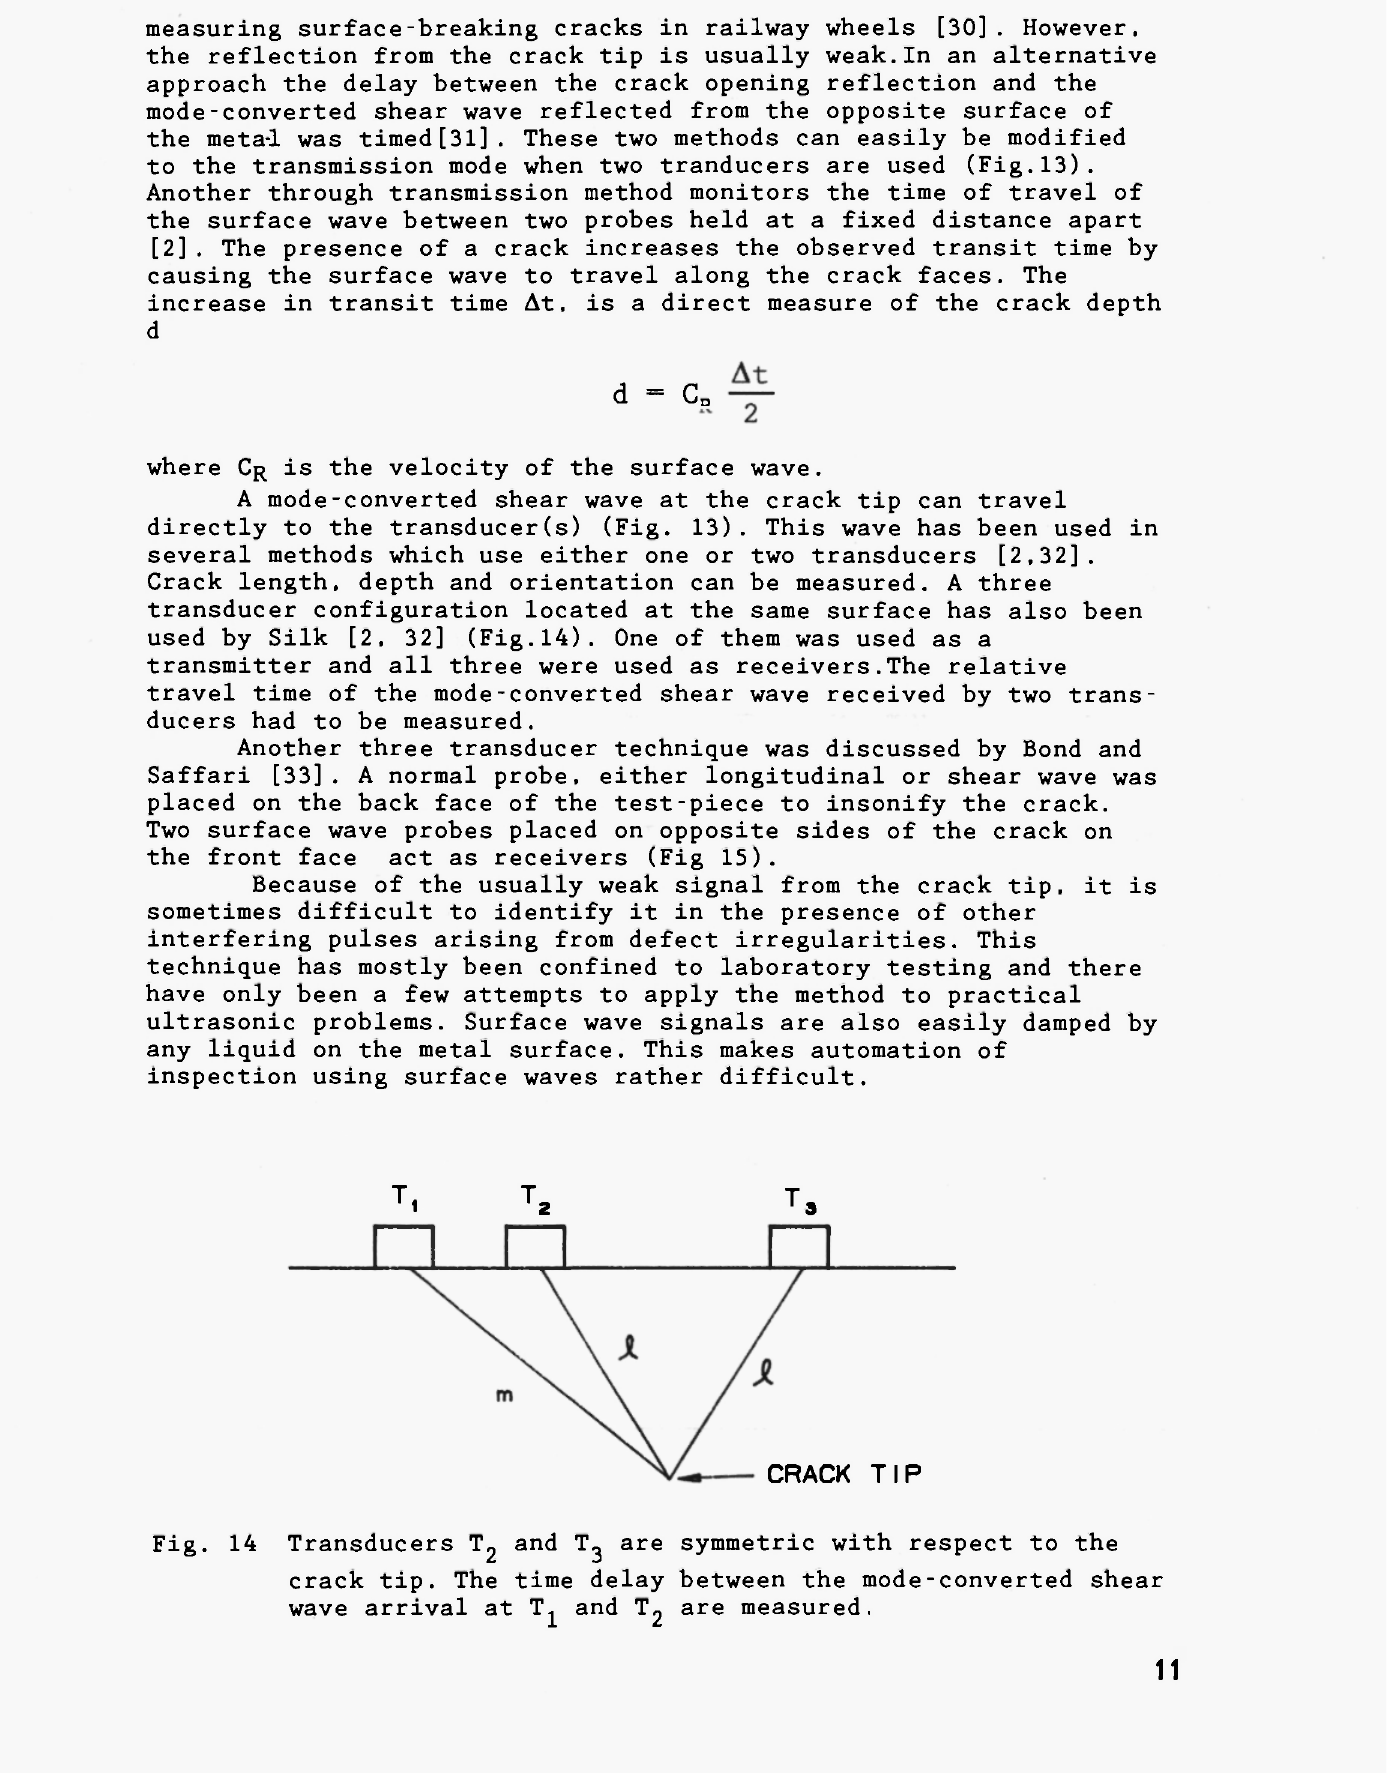
Fig. 14 Transducers T 2 and T^ are symmetric with respect to the crack tip. The time delay between the mode-converted shear wave arrival at T^ and T 2 are